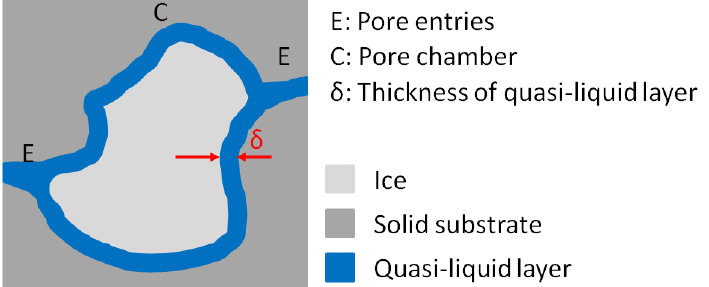
Figure 1. Cross-sectional view of a pore filled with an ice and connected with small entries. A quasi-liquid layer (QLL) with a thickness of t between the ice and the pore wall exists to achieve a physico-chemically-stable status of the confined freezing